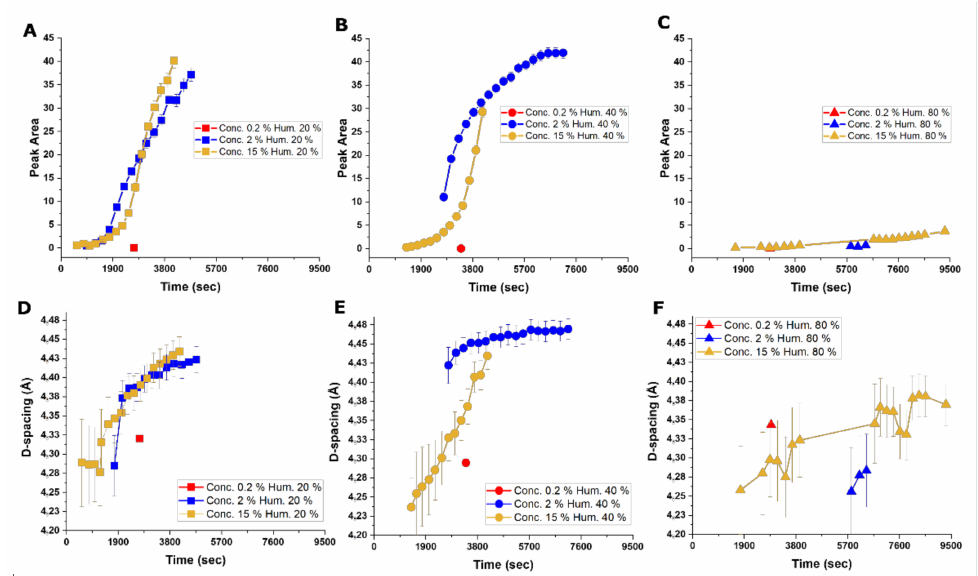
Figure 6. Effect of concentration and humidity on the formation of β -sheets analyzed by in situ X-ray scattering. ( A ) Peak fit area over time for protein concentrations of 0.2% w / v , 2% w / v , and 15% w / v protein samples at 20% RH, ( B ) at 40% RH, and ( C ) at 80% RH. ( D ) Peak fit position illustrating changes in D-spacing (shown in angstrom scale) as a function of time for protein concentrations of 0.2% w / v , 2% w / v , and 15% w / v protein samples at 20% RH, ( E ) at 40% RH, and ( F ) at 80%